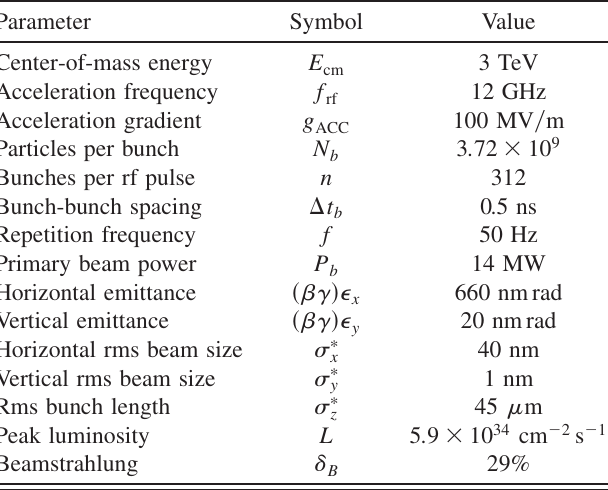
TABLE I. Incoming beam parameters at CLIC.